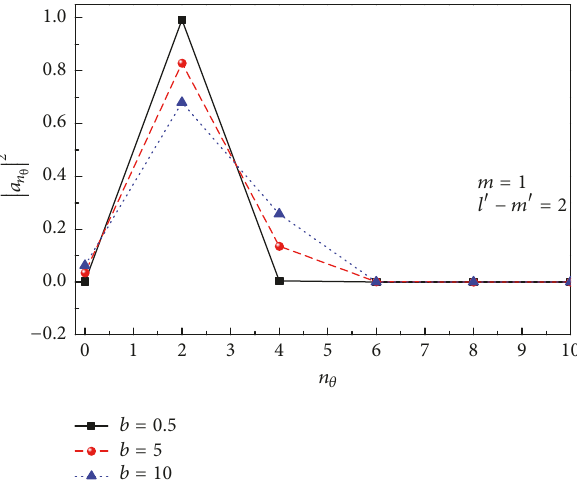
| 2 for different values 𝑏 𝜃